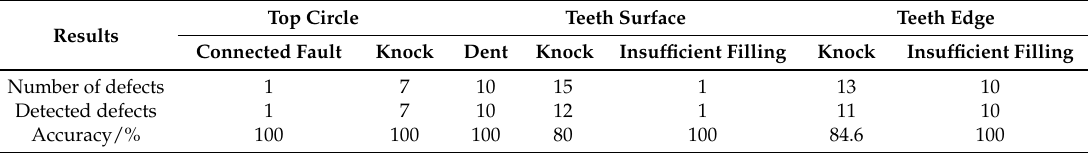
Table 2. Top surface inspection of gear A 4 .